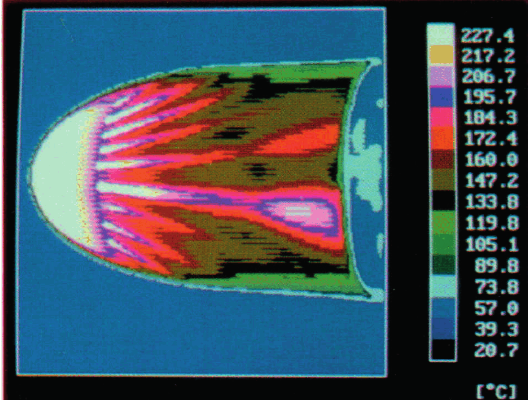
Figure 16. Temperature (in Celsius) map of the ellipsoid side (windward) of the double ellipsoid model at M = 8.15, α = 30°, 0.48 s after model injection. Flow from left to right. From de Luca et al .